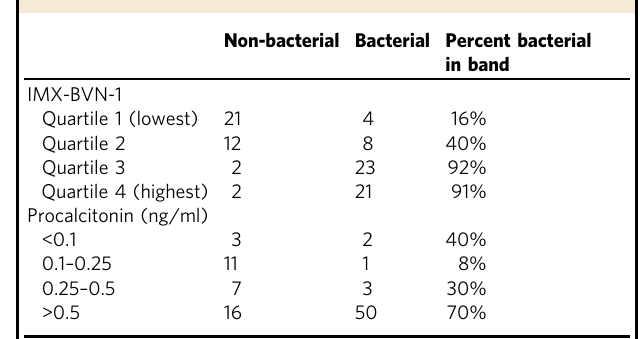
Table 3 Bacterial diagnosis by thresholds.